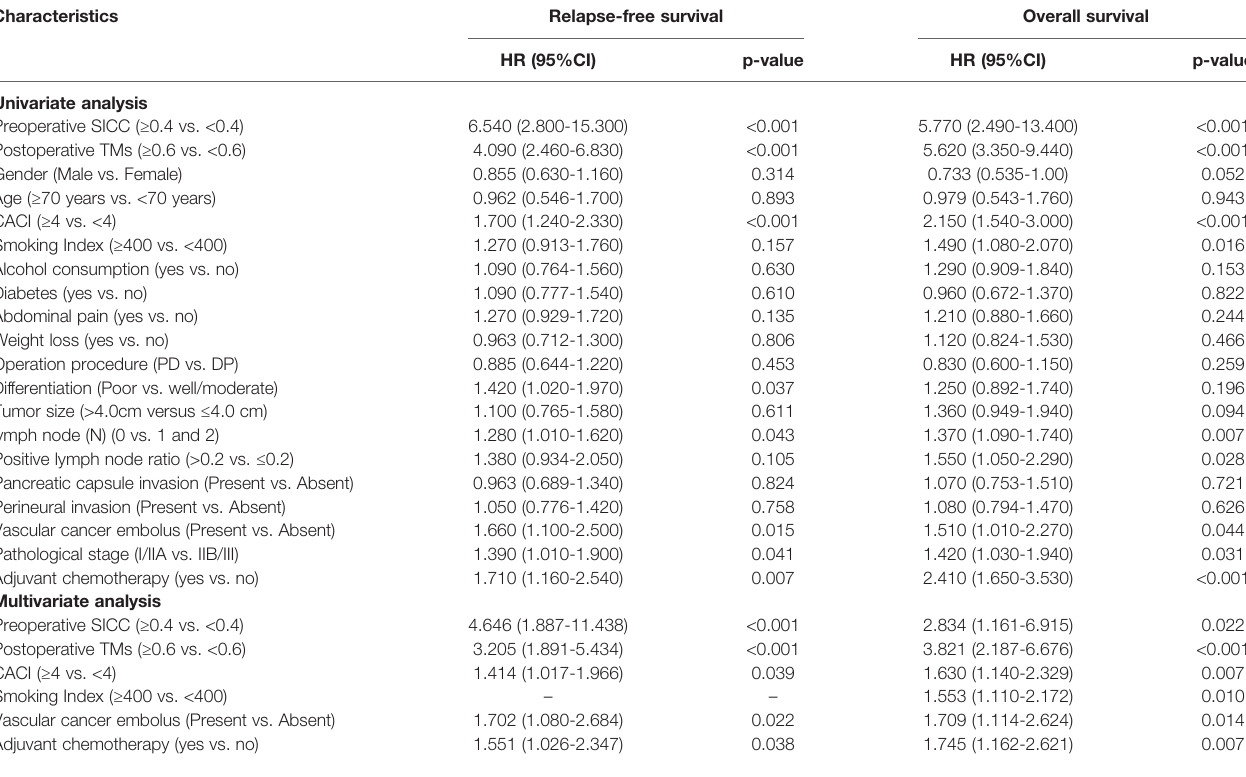
TABLE 4 | Univariate and multivariate analysis of recurrence and long-term prognosis in the training group.